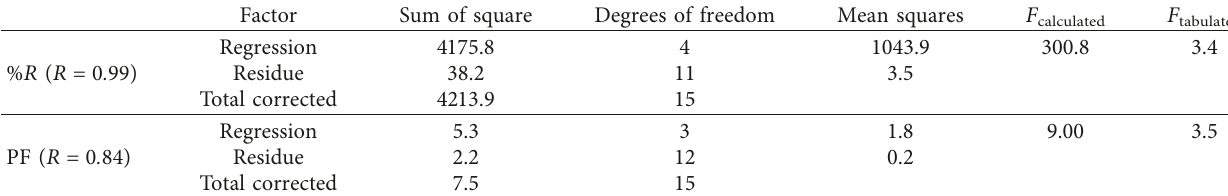
Table 3: Analysis of variance for enzyme recovery and purification